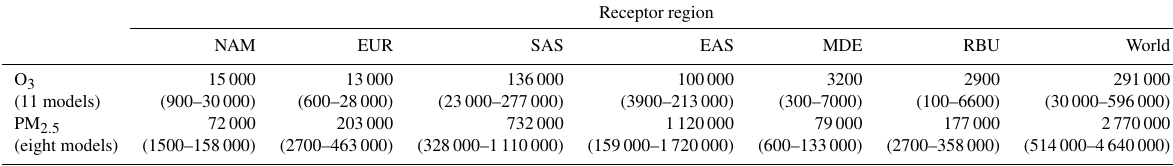
Table 4. Annual multi-model empirical mean O 3 - and PM 2 . 5 -related premature deaths with 95% CI from Monte Carlo simulations in parentheses (including uncertainty in baseline mortality rates, RRs, and air pollutant concentration across models) in the year 2010 baseline. All numbers are rounded to three significant figures or the nearest 100 deaths. Empirical mean is the mean of 1000 Monte Carlo simulations. Receptor